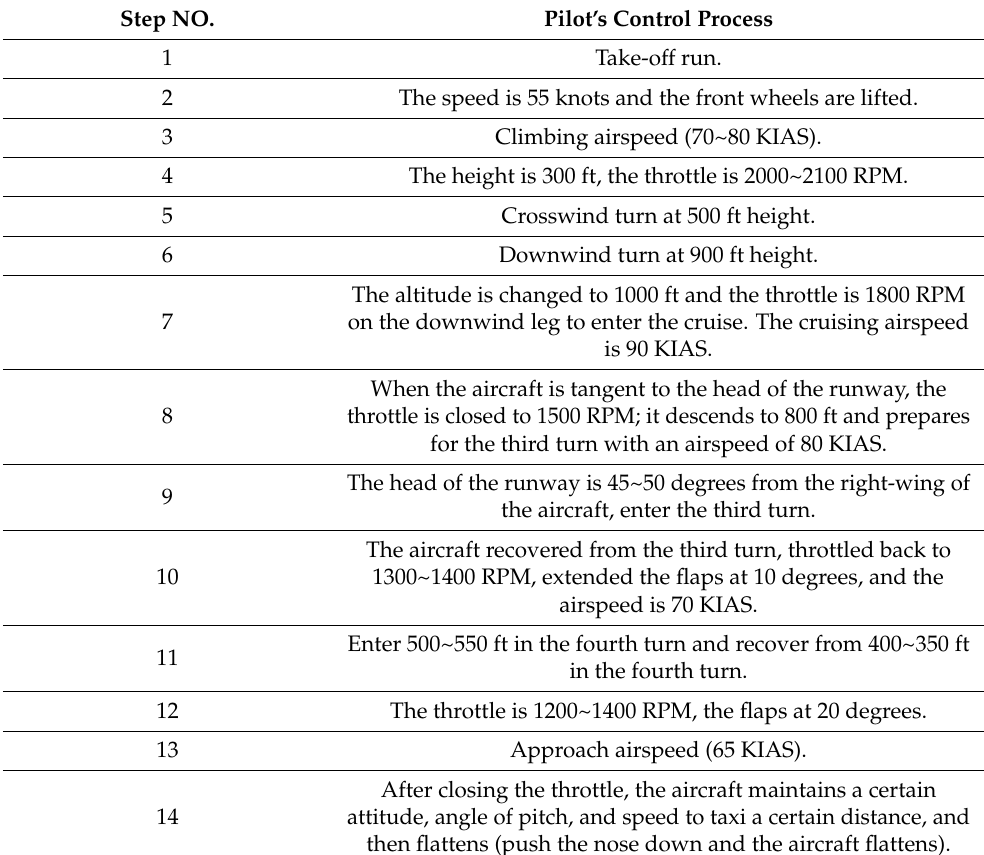
Table 1. Airfield traffic pattern control program.